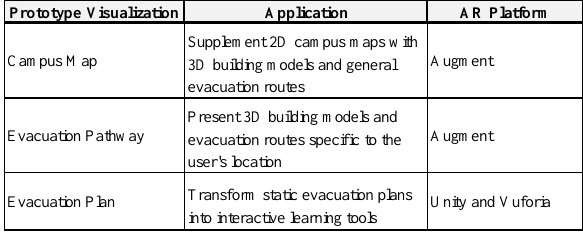
Table 1. Outline of presented AR prototypes